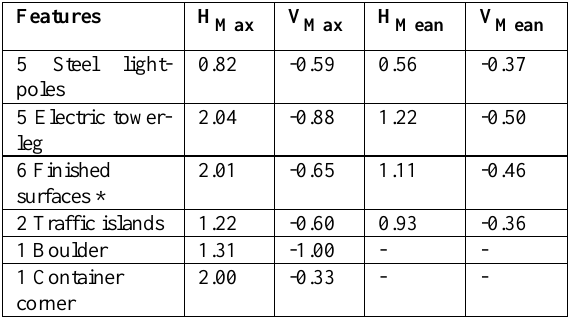
Figure 14. Results for different features